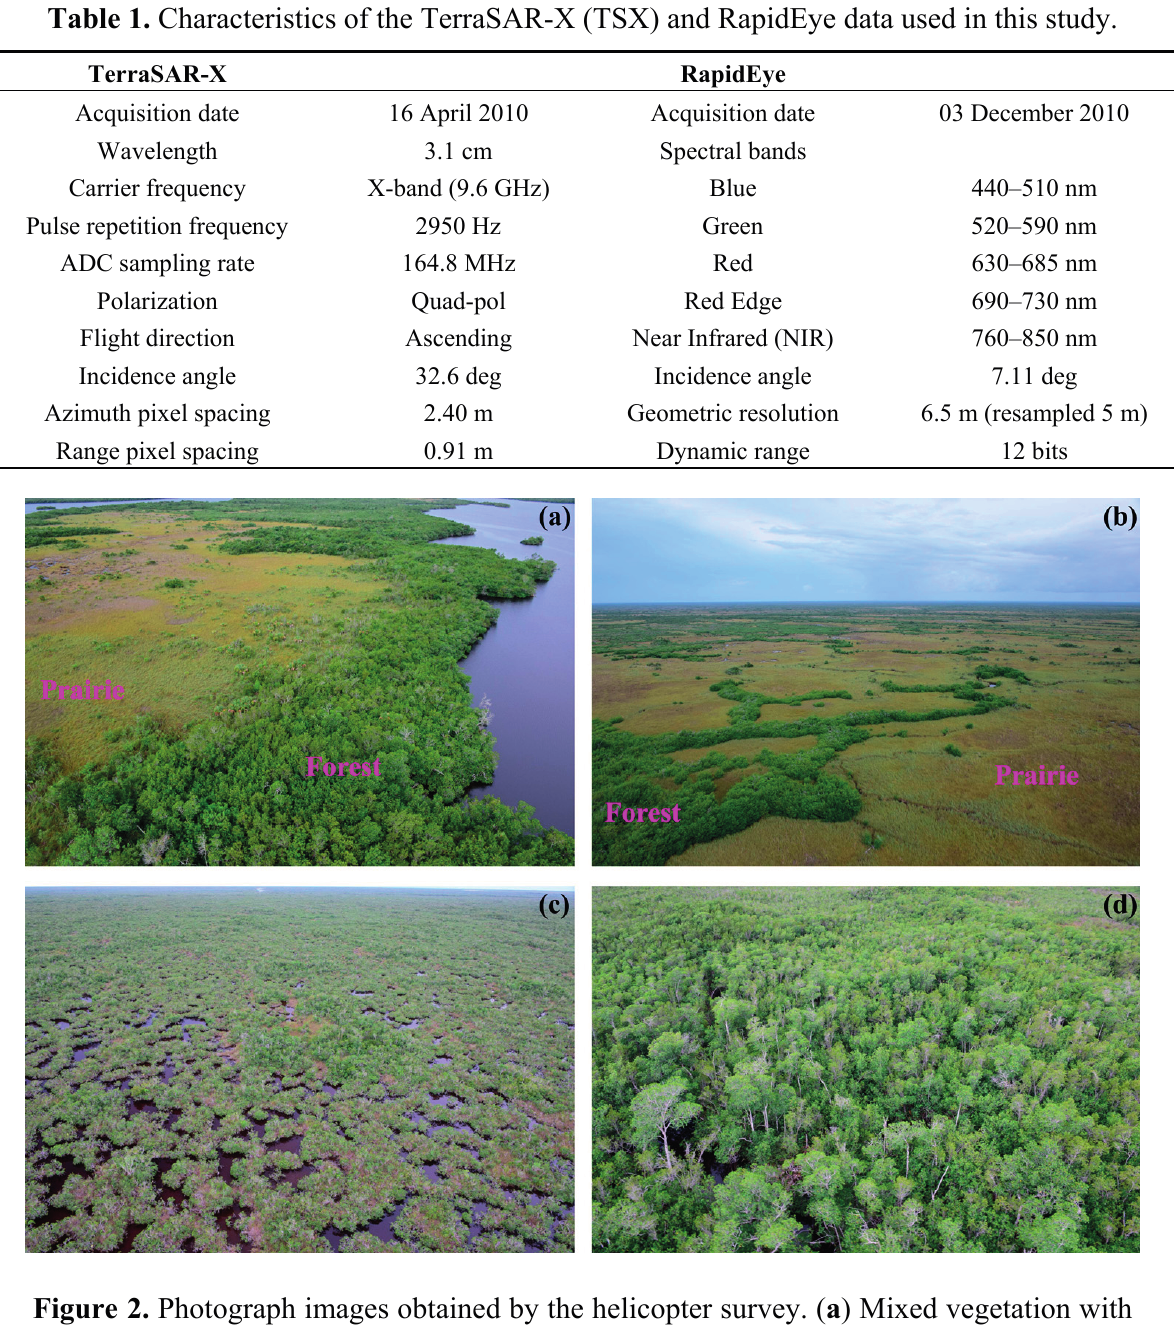
Figure 2. Photograph images obtained by the helicopter survey. ( a ) Mixed vegetation with prairie (sawgrass) and forest (mangrove); ( b ) Mixed vegetation with mostly prairie (sawgrass) and small forest (mangrove); ( c ) Scrub vegetation with short mangrove and buttonwood; ( d ) Typical mangrove dominated